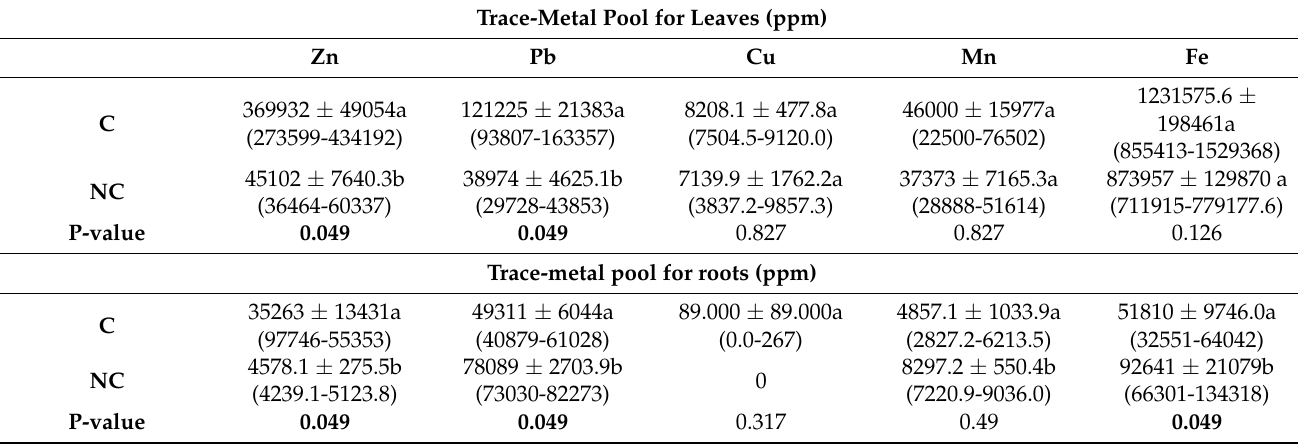
Table 4. Trace-element pools (ppm) for leaves and for roots of Dittrichia viscosa in contaminated soil (C) and uncontaminated soil (NC). The mean value ± SE is indicated and as well as the minimum and maximum values in brackets. The non-parametric Kruskal–Wallis test was applied. Different letters indicate significant differences at a significance level < 0.05 within each element and plant